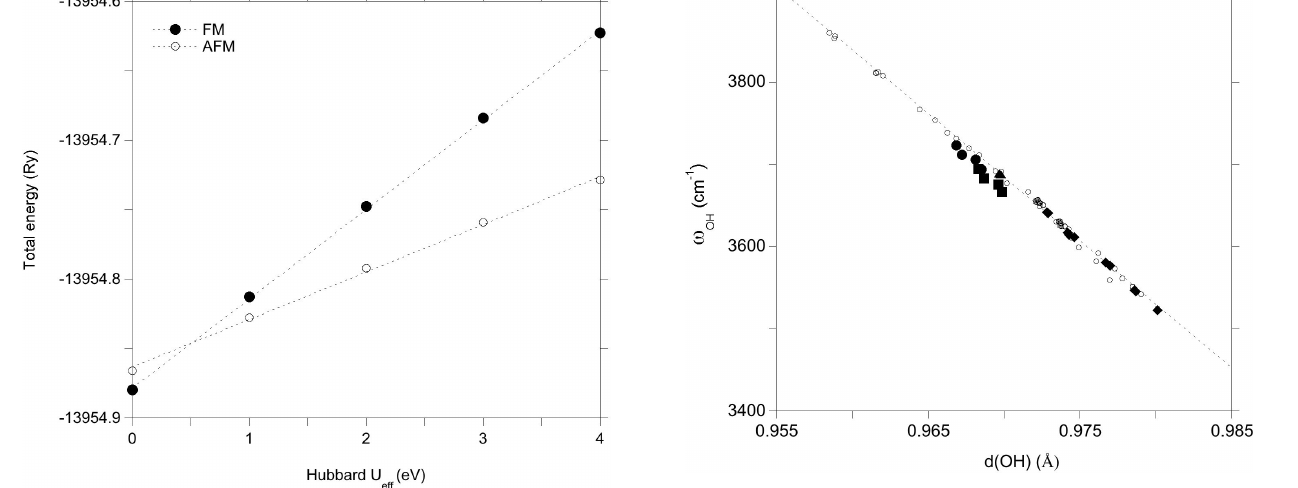
Figure 3. Total energy of the models with iron dimers and two va- cancies reported as a function of the Hubbard U eff parameter value. The anti-ferromagnetic (AFM) coupling is favored with respect to the ferromagnetic (FM) coupling in the more realistic U -corrected models.